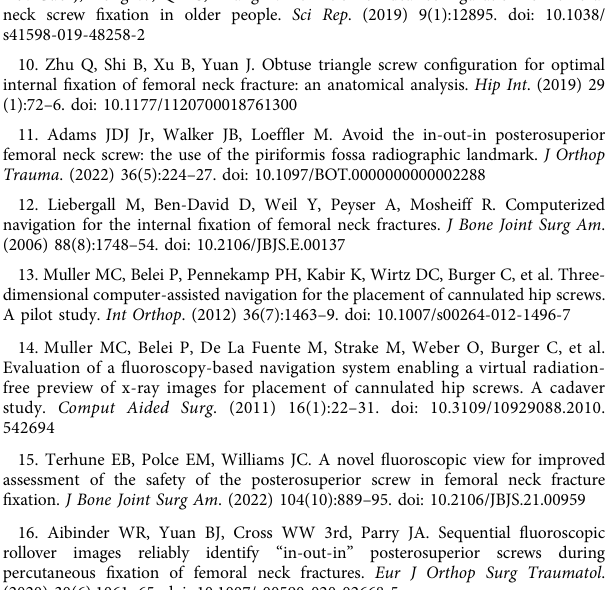
Figure S1 | Using John ’ s strategy, screw was always placed on the posteroinferior quadrant of femoral safe